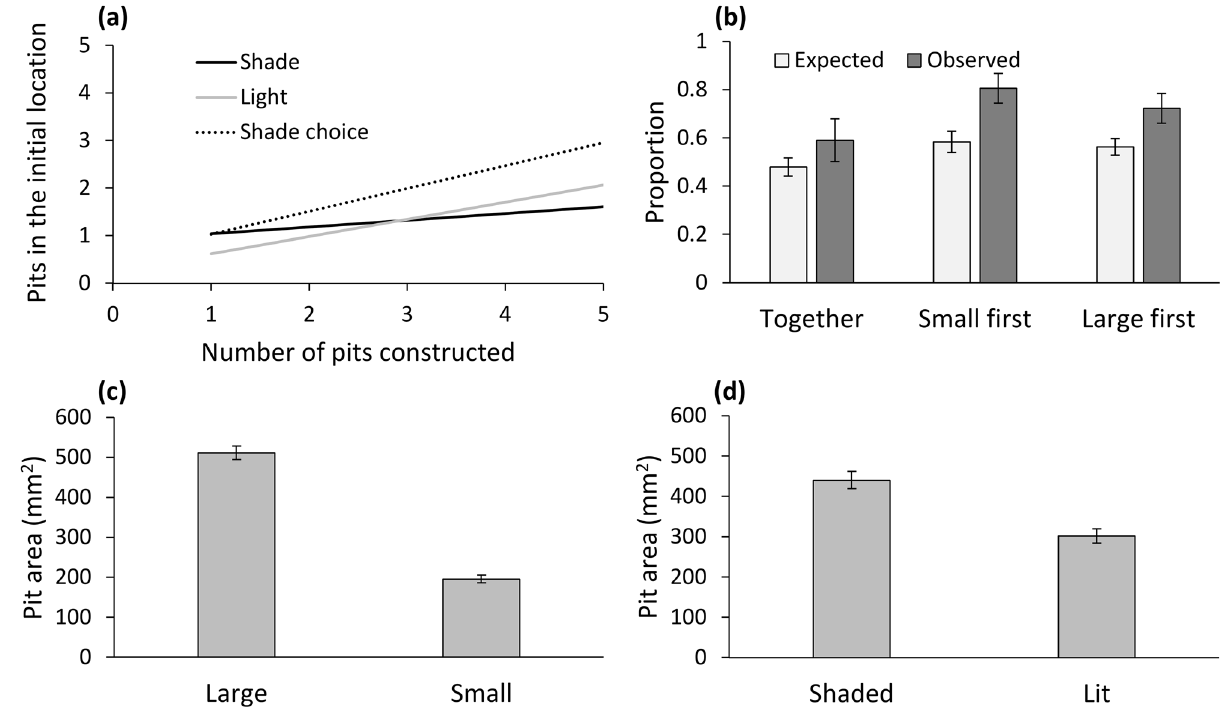
Figure 2. ( a ) The interactive effect of treatment (shade, light, or shade choice treatments) and the total number of pits in the tray on the number of pits constructed in the initial placement location. Only regression lines are shown for simplicity. ( b ) Large wormlions remained in the initial placement location (under shade) more frequently than expected by chance, independent of whether all wormlions were placed simultaneously or not. ( c ) Pits constructed by larger wormlions were larger than those constructed by smaller ones. ( d ) Pits constructed in shaded sand were larger than those constructed in lit sand. Means ± 1 SE are body mass led to a decrease in the number of pits constructed in the initial placement location (z = − 2.40, P = 0.016). Pits constructed in the initial placement location were larger than those constructed elsewhere in the tray (z = 3.43, P = 0.001), and this pattern was more pronounced in the depth choice treatment (z = 2.28, P = 0.022; Fig. 3a). Pits constructed in the deep sand treatment were larger than those constructed in the depth choice treatment (z = − 2.33, P = 0.020), and also tended to be larger than those constructed in the shallow sand treatment (z = − 1.89, P = 0.058). The effect of pit location on pit area did not differ between the deep and shal- low sand treatments (z = − 1.83, P = 0.067). As expected, pit area increased with body mass (z = 9.02, P < 0.001). Experiment 4: competition between small and large wormlions. Large wormlions constructed pits in the pre- ferred deep sand more frequently than small wormlions (F 1,69 = 34.76, P < 0.001; Fig. 3b). There was no signifi- cant effect of treatment (placing the small wormlions 2 h earlier or later vs. all simultaneously) on the outcome (F 1,69 = 0.12, P = 0.889). Regarding pit area, large wormlions constructed larger pits, with this pattern being more pronounced in deep sand (body size × sand depth interaction; z = 6.68, P < 0.001; Fig. 3c). Size as main effect was significant as well (z = 3.22, P = 0.001), while sand depth was not (z = 0.43, P = 0.668). Treatment interacted with sand depth to affect pit area (z = 2.03, P = 0.042): Pits in deep sand were larger, when large wormlions arrived 2 h before the small wormlions, compared to a simultaneous arrival (Fig. 3d). All other two-way interactions were not significant and hence removed ( P > 0.131). Experiment 5: competition among small and large wormlions over a limited area. Larger individuals constructed larger pits (z = 7.38, P < 0.001). Pit area of both was smaller when the two wormlions were together than when alone (z = − 2.87, P = 0.004; Fig. 4), and this pattern held true for both large and small wormlions (z = 1.24, P = 0.214). Treatment order, first together or first alone, had no significant effect on pit area (z = − 1.67, P = 0.095). Experiment 6: cannibalism. Cannibalism took place in 6 out of the 139 pairs, the larger wormlion always being the cannibal (see photos in the Supplementary Material). Neither the body mass of the small wormlion, nor the body mass of the large wormlion, nor the difference in their body masses affected the probability of can- nibalism (z = 1.77, P = 0.077; z = 1.66, P = 0.097; z = 1.41, P = 0.157). However, the absence of significant results probably stems from the limited number of positive cases. All the victims were smaller than 3.0 mg, with 40% of the small larvae being larger than this threshold.